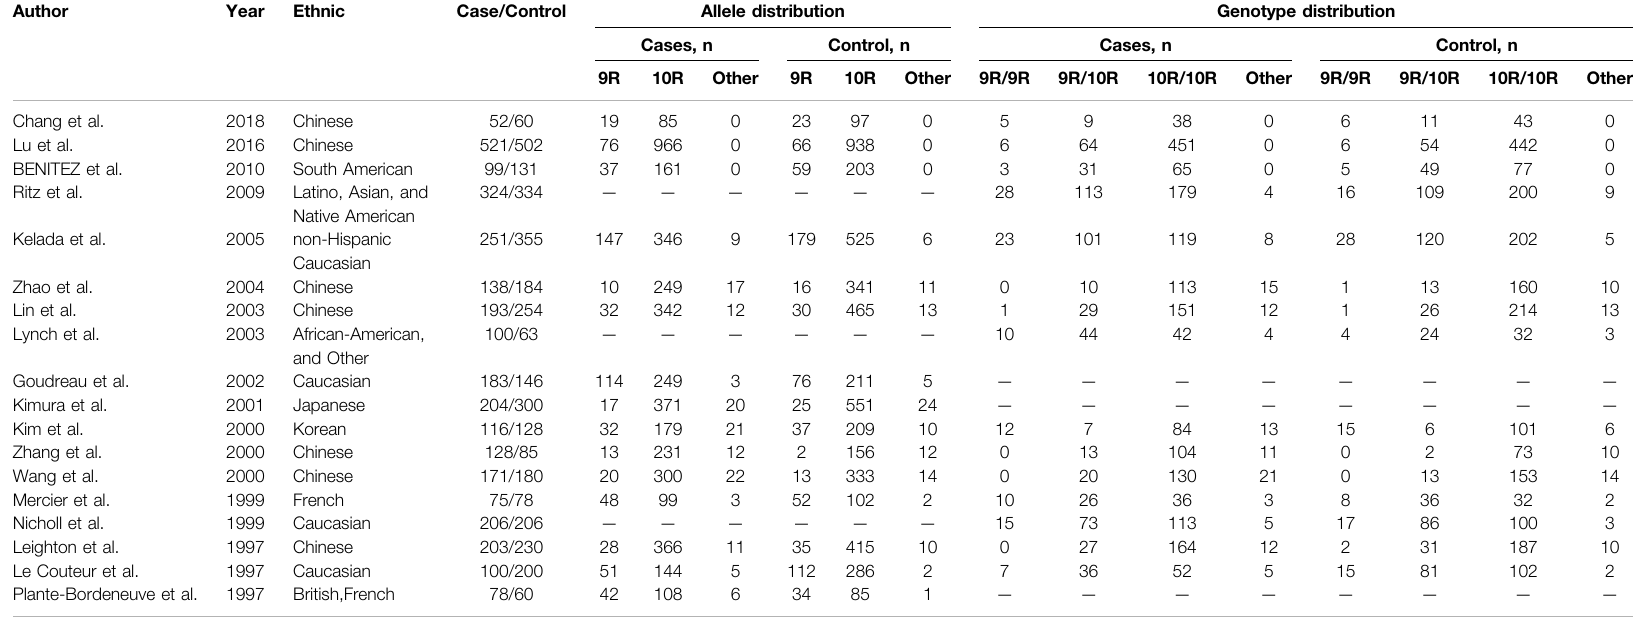
TABLE 1 | Characteristics of each study included in this